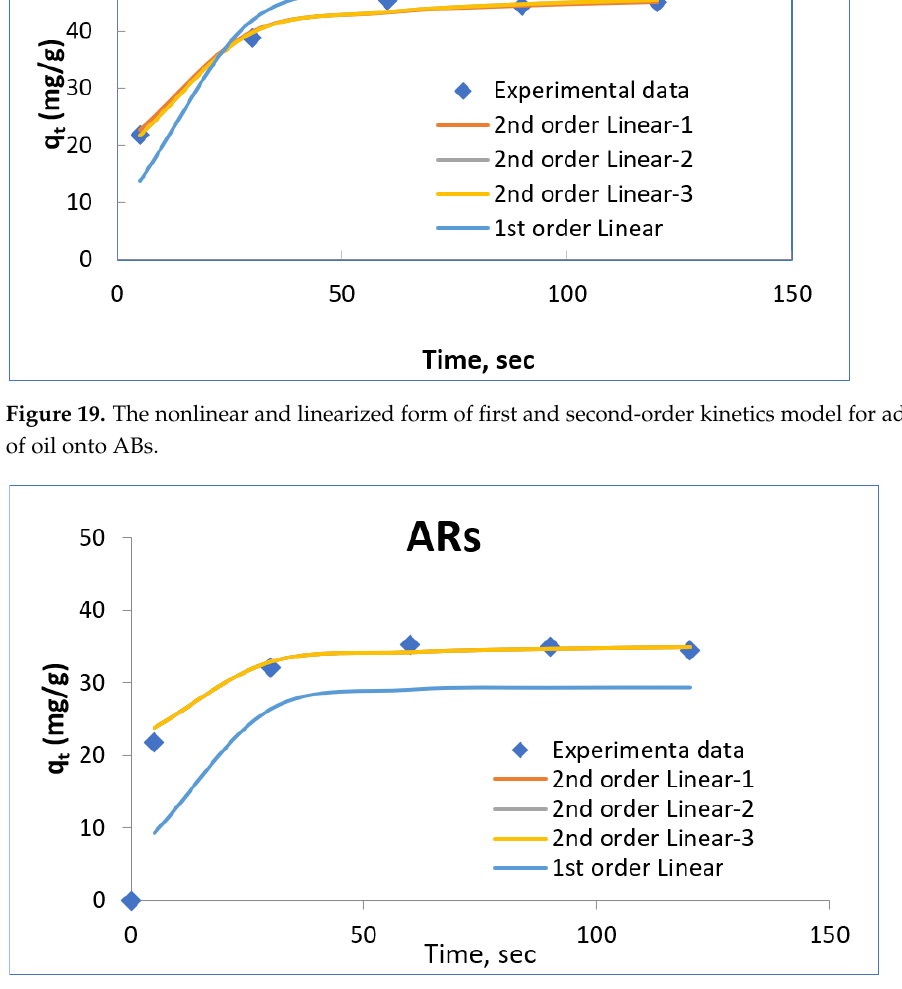
Figure 20. The nonlinear and linearized form of first and second-order kinetics model for adsorption